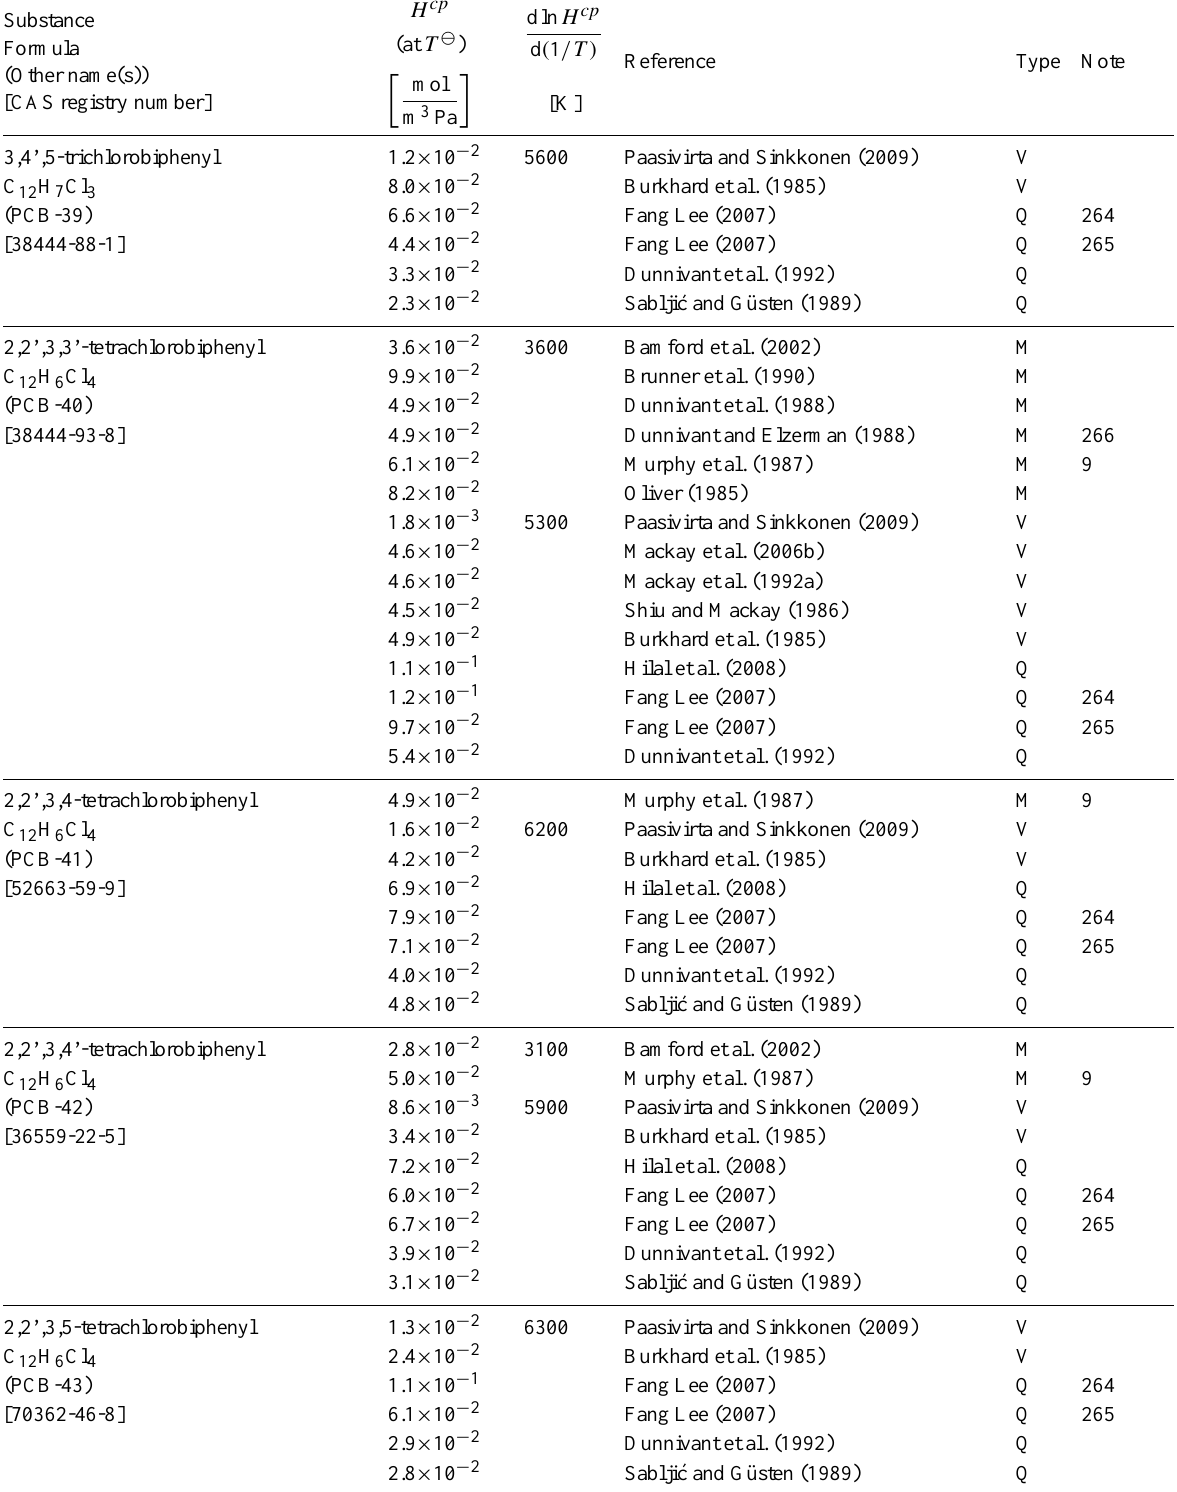
Table 6: Henry’s law constants for water as solvent